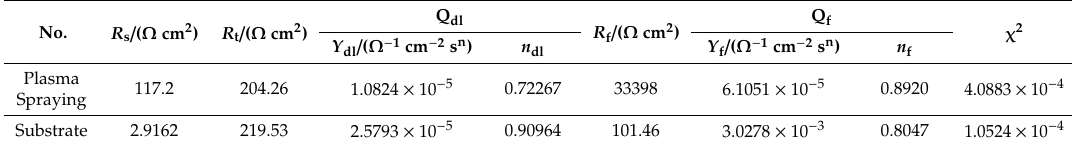
Table 9. Fitting results of the equivalent circuit of the alternative current impedance spectra of the substrate and plasma spraying